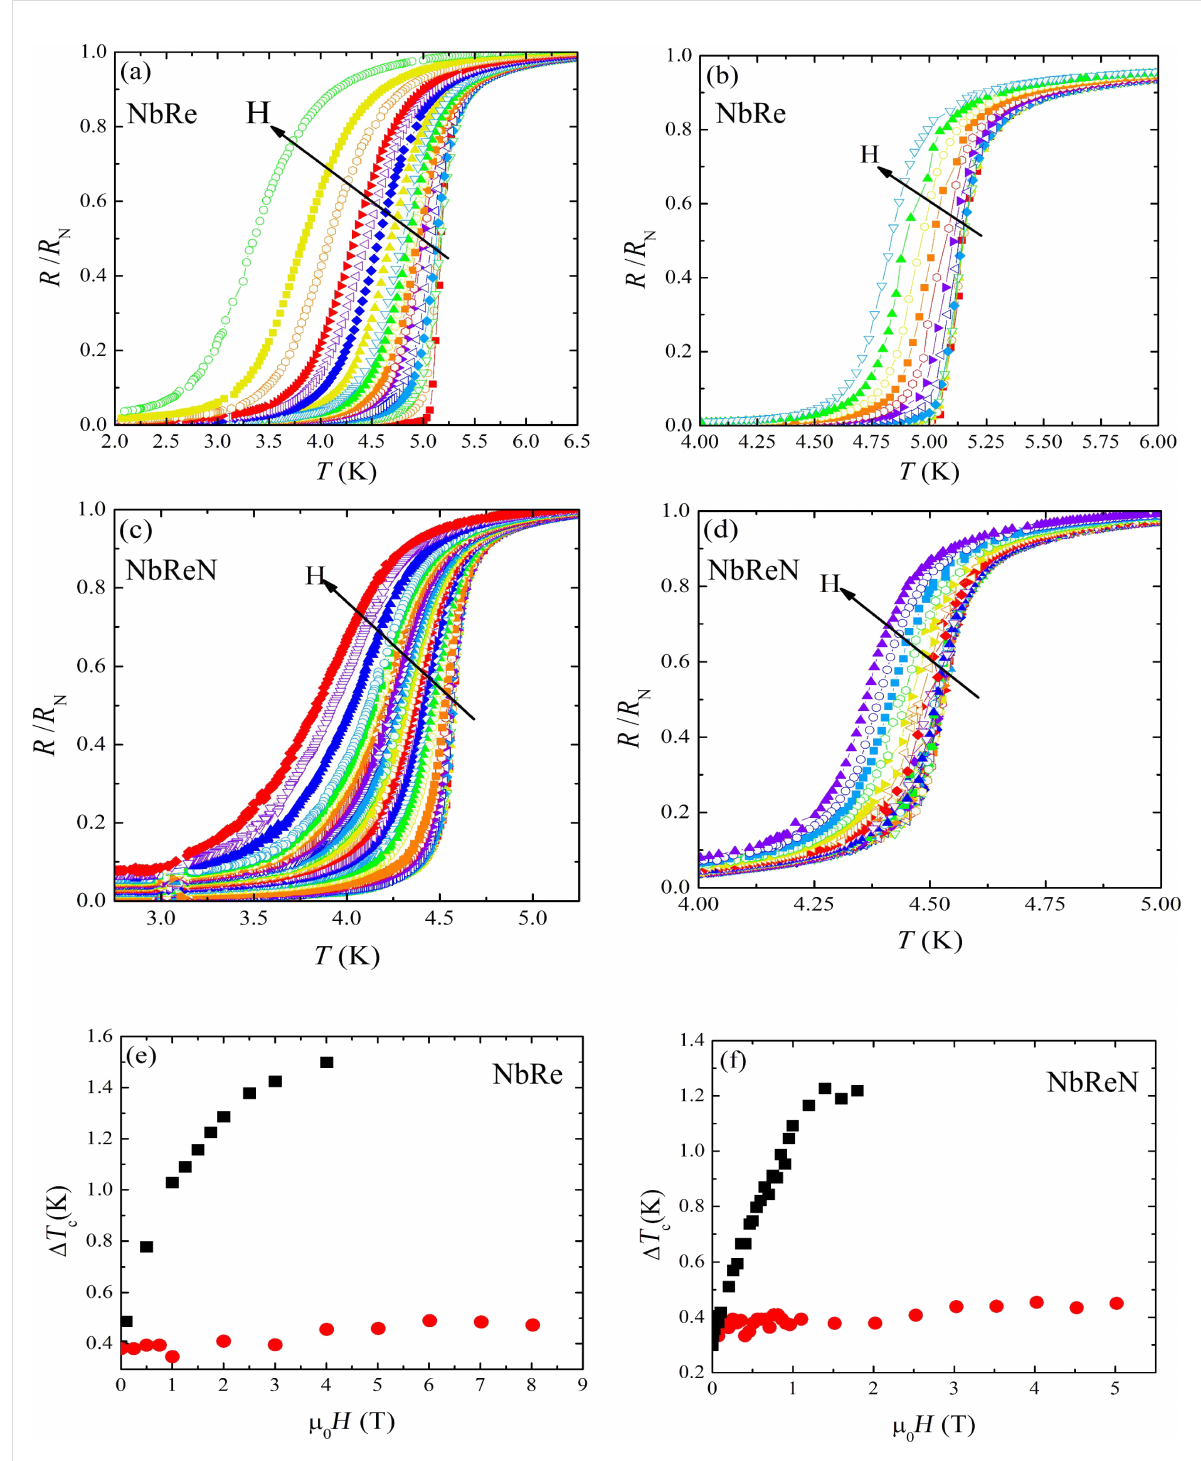
Figure 2: (a) Temperature dependence of the resistance of the NbRe microstrip in various magnetic fields in the perpendicular geometry. The curves have been measured for increasing magnetic fields (as indicated by the arrow) from μ 0 H = 0.003 to 4 T. (b) The same as panel (a) but in the parallel geometry. The field increases from μ 0 H = 0.003 to 8 T. (c) Temperature dependence of the resistance of the NbReN microstrip in various magnetic fields in the perpendicular geometry. The curves have been measured for increasing magnetic fields from μ 0 H = 0.001 to 3 T. (d) The same as panel (c) but in the parallel geometry. The field increases from μ 0 H = 0.007 to 5 T. (e, f) Δ T c field dependence of (e) the NbRe and (f) the NbReN microstrip for the perpendicular (black squares) and parallel (red circles)